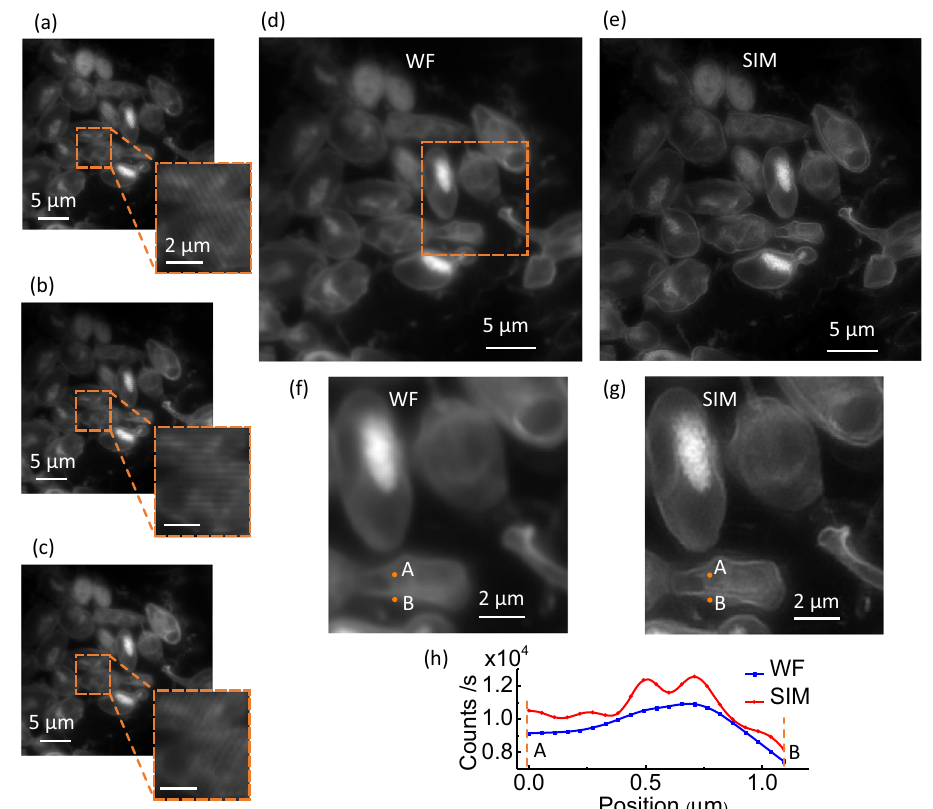
Fig. 5 | UV-PIC SIM on yeast cells. a – c Auto fl uorescence image of NADH in yeast cellsunderUVstructuredilluminationwith D 1 , D 2 ,and D 3 orientations,respectively. Theinsertisathreetimesmagni fi edzoomoftheareade fi nedbytheorangedotted contourtohighlightthemodulationpatternsofthe fl uorescenceintensityresulting from the structured illumination. d Standard wide- fi eld and e reconstructed SIM